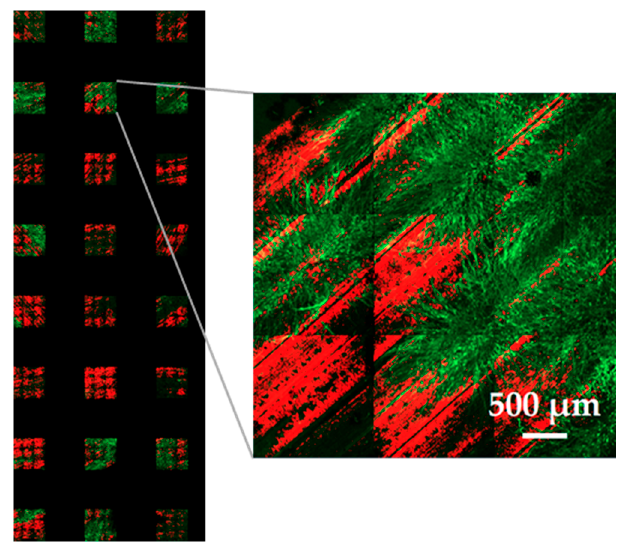
Figure 3. Merged z -stack 3 × 3 tiled images of 4-amino-5-methylamino-2’,7’-difluorofluorescein diacetate (DAF-FM-DA) stained discs of Blumeria graminis f. sp. hordei ( Bgh ) - infected barley leaves in the first 3 columns of a 96-well plate. Enlarged: merged image of a single well. Chlorophyll fluorescence is shown in red, DAF-FM DA fluorescence in green.